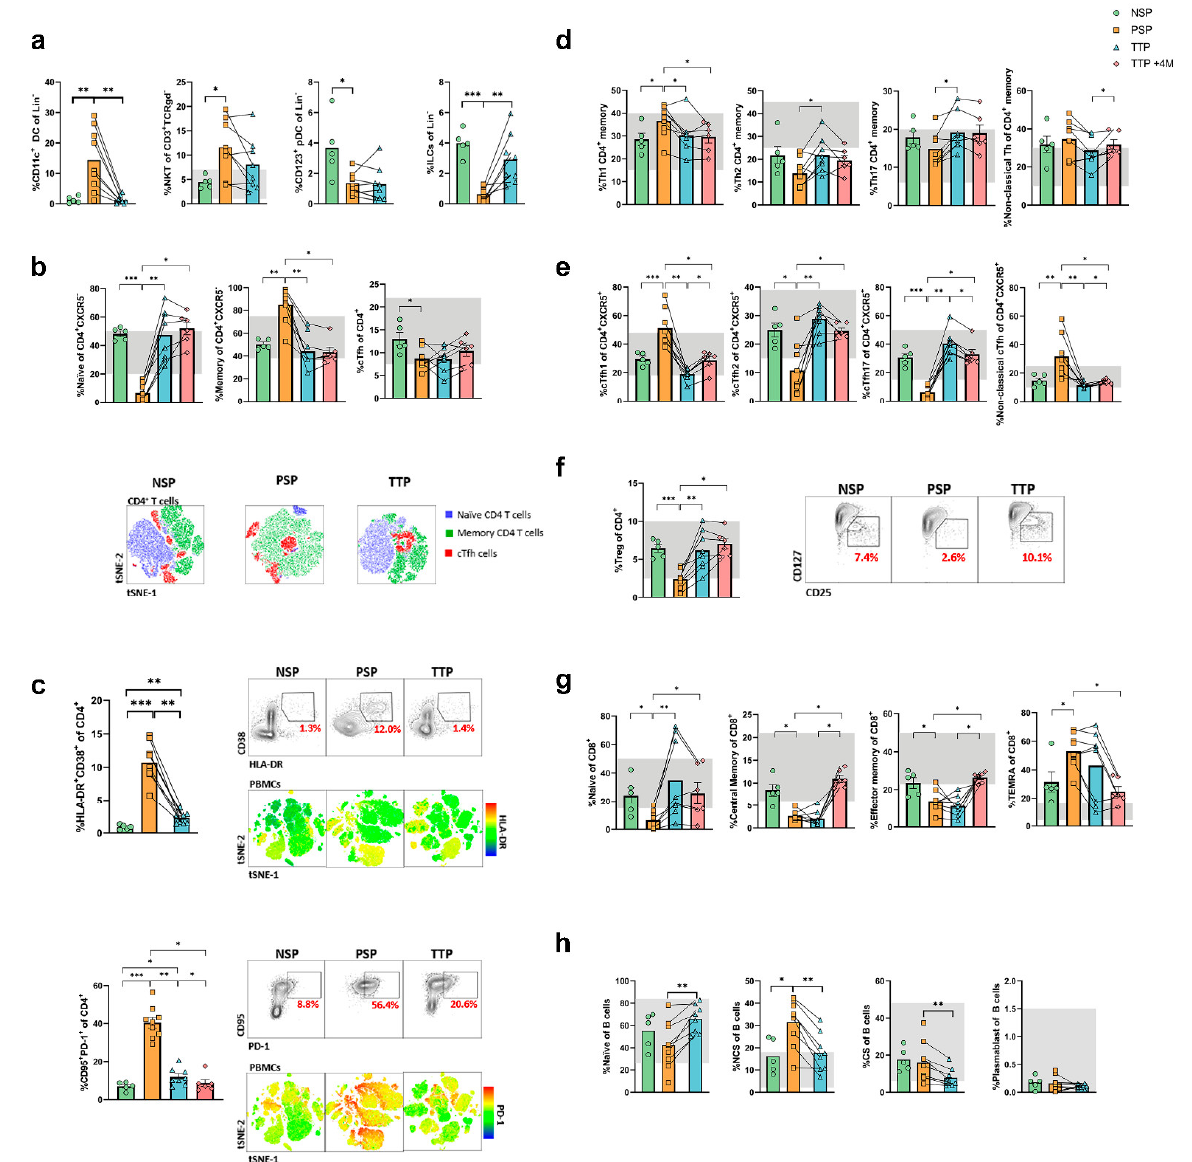
Figure 2. Immunological alterations in PSP include dysregulated innate and adaptive populations together with higher expression of activation factors. Comparison between NSP, PSP, TTP, and TTP+4M of ( a ) conventional dendritic cells (CD11b+ DC), natural killer T lymphocytes (NKT), plasmacytoid DC (CD123+ pDC), and innate lymphoid cells (ILC); ( b ) naïve, memory, and follicular helper T CD4+ lymphocytes; ( c ) expression of HLA-DR and CD38 and expression of CD95 and PD-1 on CD4+ T lymphocytes; ( d ) subsets of memory CD4+ T cells based on CXCR3 and CCR6 expression; ( e ) subsets of follicular helper T CD4+ lymphocytes; ( f ) regulatory T cells (Treg); ( g ) naïve, central memory (TCM), effector memory (TEM), and effector memory re-expressing CD45RA (TEMRA) CD8+ T cells; and ( h ) naïve, non-class-switched memory (NCS), class-switched memory (CS), and plasmablast B cells. Grey regions depict percent populations ranges, if available, obtained from groups of representative healthy donors in our clinical immunology laboratory. In ( b ), tSNEs were performed by using all 37 fluorochromes (see Methods); and in ( c ), tSNEs were performed in total CD4+ cells and using CXCR5, CD27, CCR7, CD45RA, CCR6, and CXCR3. *, p < 0.05; **, p < 0.01; ***, p < 0.001.